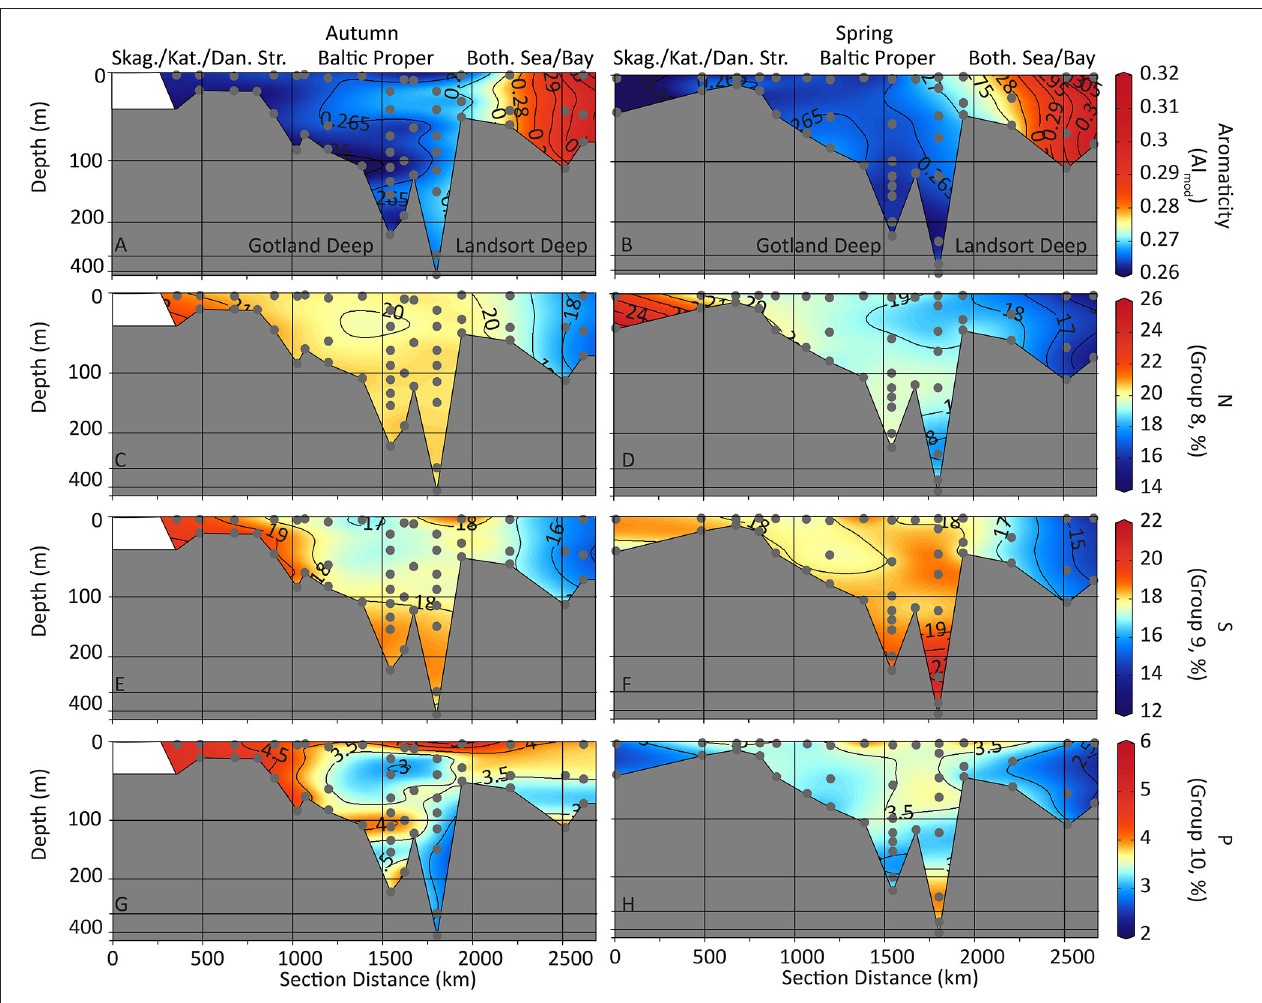
FIGURE 5 | Contour depth plots of the sampling transects. Weighted averages of DOM aromaticity (AI mod ; A,B ) and compound groups of DOM containing nitrogen (C,D) , sulfur (E,F) , or phosphorus (G,H) (DOM groups 8, 9, and 10) are shown for autumn (left) and spring (right) sampling. Averages are weighted by FT-ICR-MS signal intensity. Non-linear depth scale. Skag., Skagerrak; Kat., Kattegat; Dan. Str., Danish Straits; Both. Sea/Bay, Bothnian Sea and Bothnian Bay.